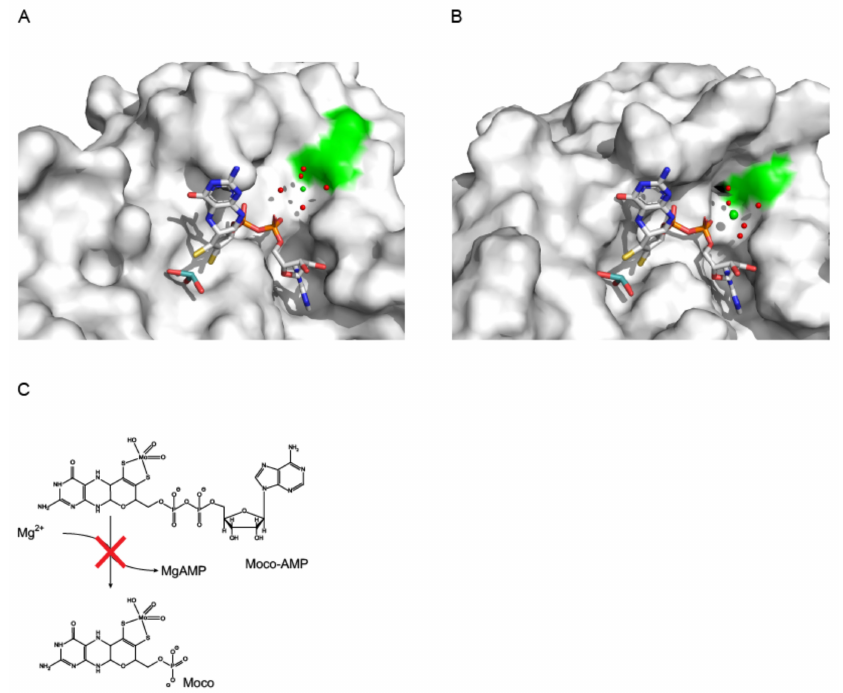
Figure 8. Understanding E-domain functionality: Site by site comparison of MoeA and Cnx1E. Active site view of MoeA ( A , PDB entry: 1FC5, [49]) and Cnx1E variant S269D D274S ( B , PDB entry: 6Q32, [14]). The molecular surface is shown, the first identified, catalytically important residue ( A , D228, MoeA, [48,49]) and its counterpart in Cnx1E (D242 ( B ), [14,26]) are highlighted in green. Moco-AMP is shown in stick notation. The Moco-AMP molecule shown in ( A ) has been placed into the active site based upon a superimposition of the Cnx1 E-domain S269D D274S variant (PDB entry: 6Q32, [14]) and MoeA (PDB entry: 1FC5 [49]). Atoms are colored as follows: carbon, grey; oxygen, red; nitrogen, blue; phosphorous, orange; sulfur, yellow; cupper brown. Hydrogen atoms are omitted. ( C ) The Mo-insertase E-domain catalyzes the insertion of molybdate into MPT-AMP and the subsequent hydrolysis of the Moco-AMP phosphoanhydride bond, a reaction that is impaired when Mg 2+ binding to the enzyme is abolished. Figure panels A and B were created with PyMOL